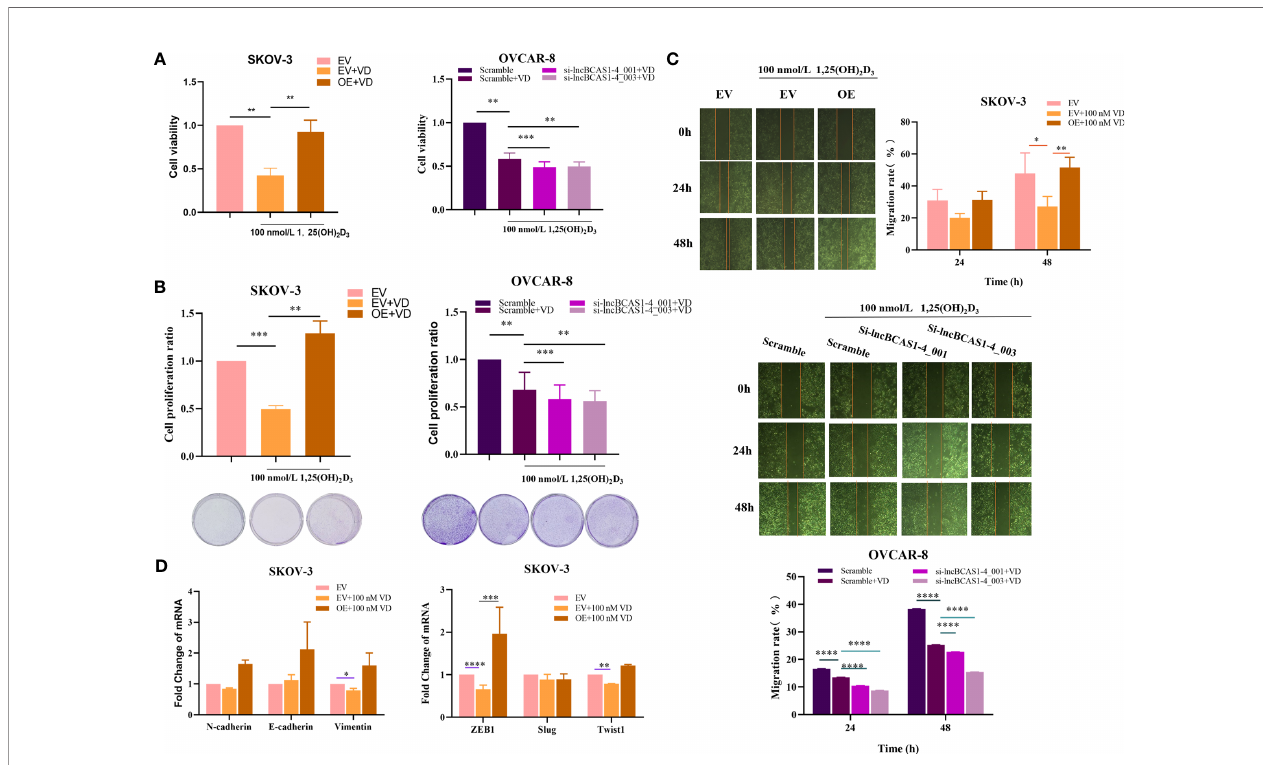
FIGURE 5 | Effect of lncBCAS1-4_1 on proliferation and migration in ovarian cancer cells treated with 1 a ,25(OH) 2 D 3 . (A) The cell viability was detected by CCK-8 after lncBCAs1-4-gain SKOV3 and -loss OVCAR8 cells treated with 1 a ,25(OH) 2 D 3 for 48 h. (B) The proliferation activity was detected by colony formation assay, after lncBCAs1-4-gain SKOV3 and -loss OVCAR8 cells treated with 1 a ,25(OH) 2 D 3 for 48 h. (C) The migration capacity was measured by wound healing assay, after lncBCAs1-4-gain SKOV3 and -loss OVCAR8 cells treated with 1 a ,25(OH) 2 D 3 for 48 h. (D) The mRNA levels of EMT-related genes were measured using RT-PCR. * p < 0.05, ** p < 0.01, *** p < 0.001, **** p <